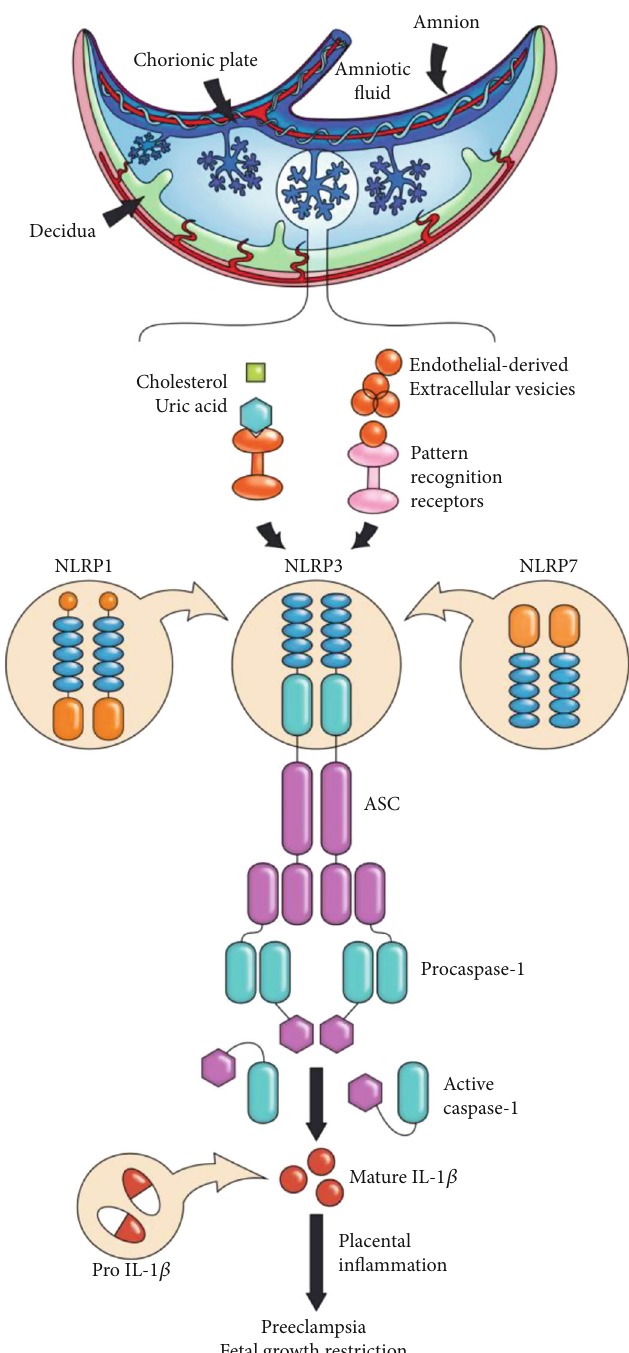
Figure 1: In fl ammasomes in placental in fl ammation. Endothelial-derived extracellular vesicles and/or alarmins (e.g., cholesterol or uric acid) can activate the NLRP3, NLRP1, and NLRP7 in fl ammasomes in the placenta, leading to the processing and release of active caspase-1 and mature IL-1 β . The resulting in fl ammation may lead to placental diseases such as preeclampsia and fetal growth